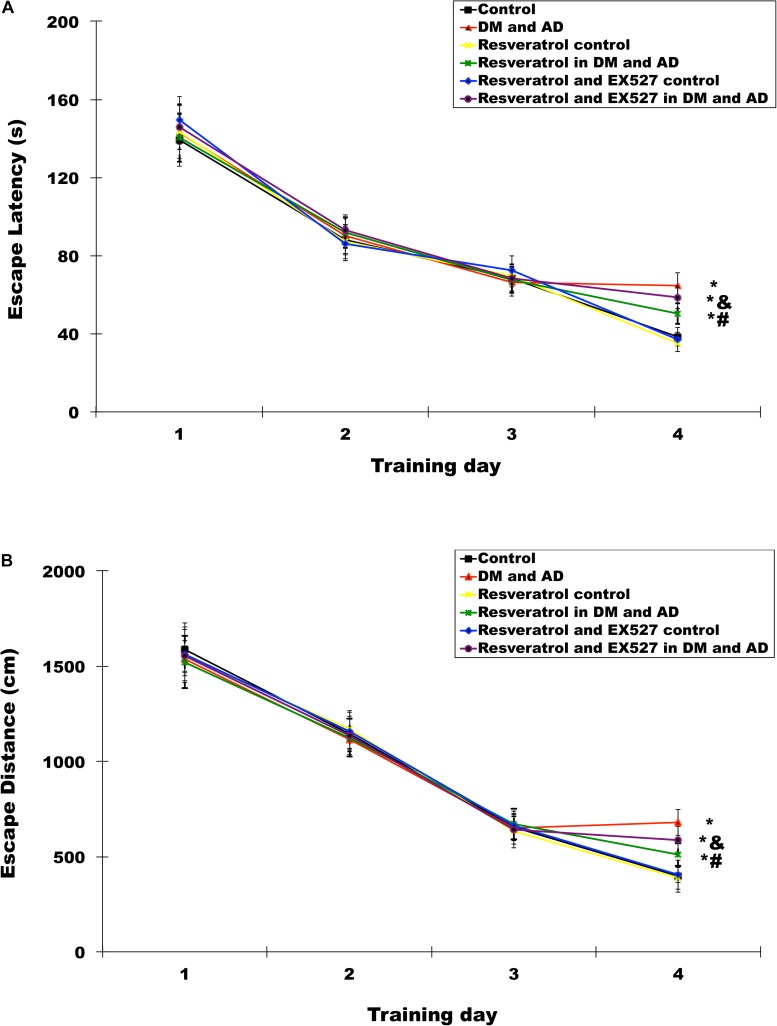
Effects of resveratrol on memory impairment in Diabetes mellitus (DM) and Alzheimer’s disease (AD) rats. The Morris water maze (MWM) was used to test rats’ memories by measuring escape latency (A) and escape distances (B). Three independent experiments were performed. Data are expressed as mean ±SD; ∗P < 0.05 vs. control group, #P < 0.05 vs. DM and AD group, &P < 0.05 vs. resveratrol in DM and AD group.